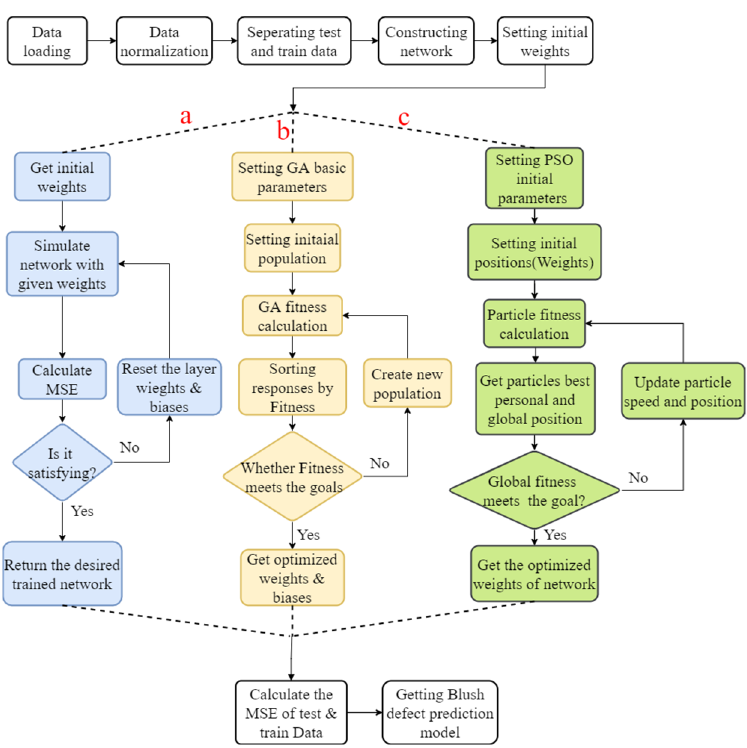
Figure 5. Training flowchart of: (a): basic ANN, (b): ANN + GA, (c): ANN + PSO.